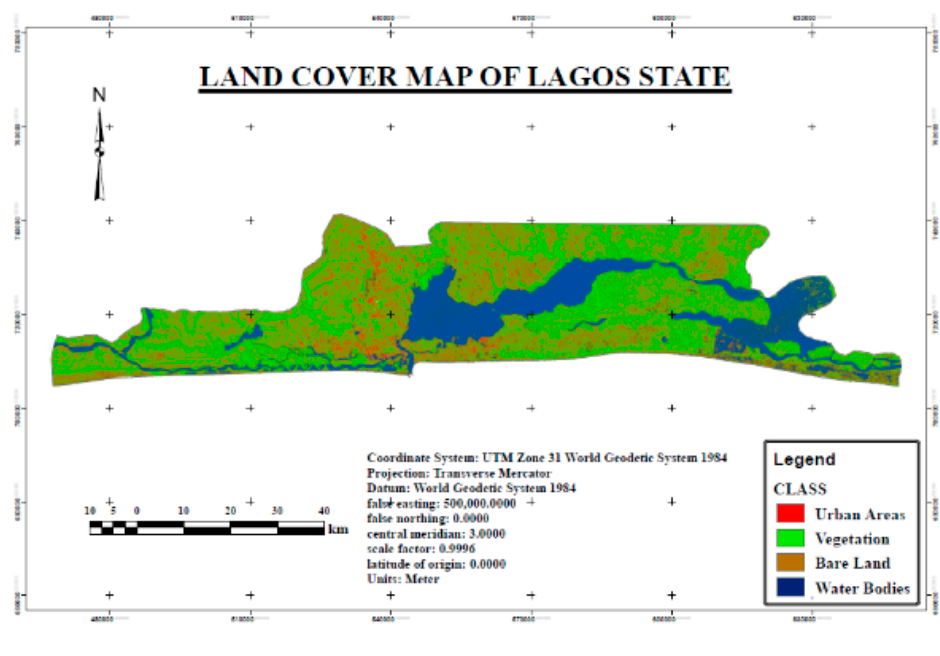
Figure 3. Classified